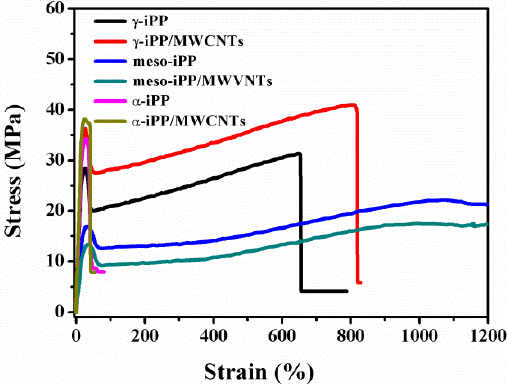
/ MWCNTs composites.